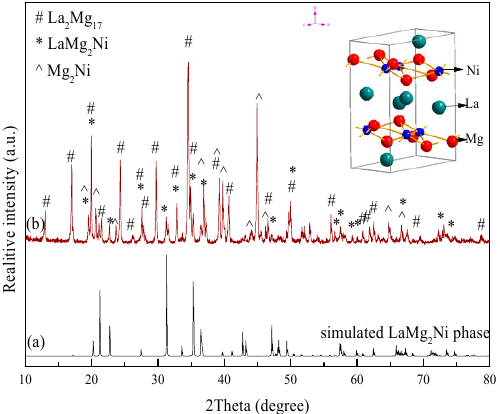
Figure 1. XRD patterns of the La 7.0 Mg 75.5 Ni 17.5 alloy: ( a ) simulated LaMg 2 Ni phase; ( b ) as-cast and crystal structure of LaMg 2 Ni.